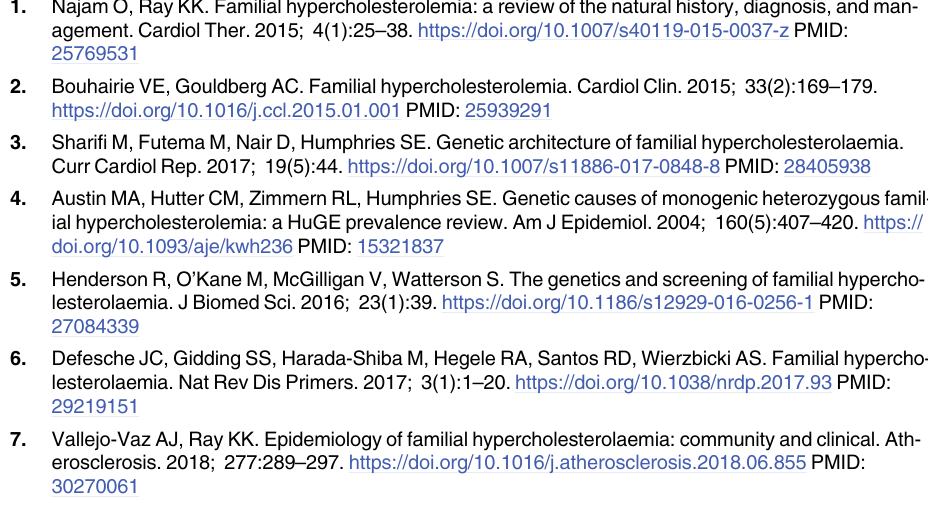
S1 Table. Number and percentage of missing values in predictor variables. S2 Table. Final model fit for LR model, combined with SMOTE method.